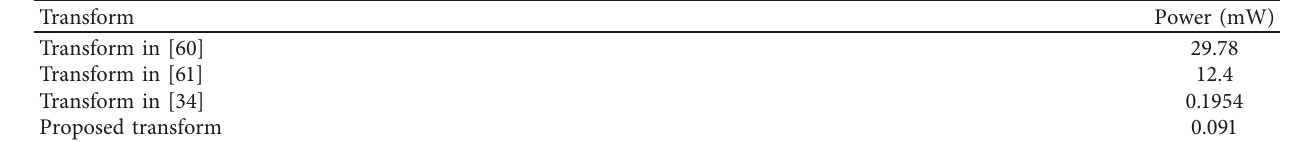
Table 5: Comparison of the proposed DCT with the previous works.